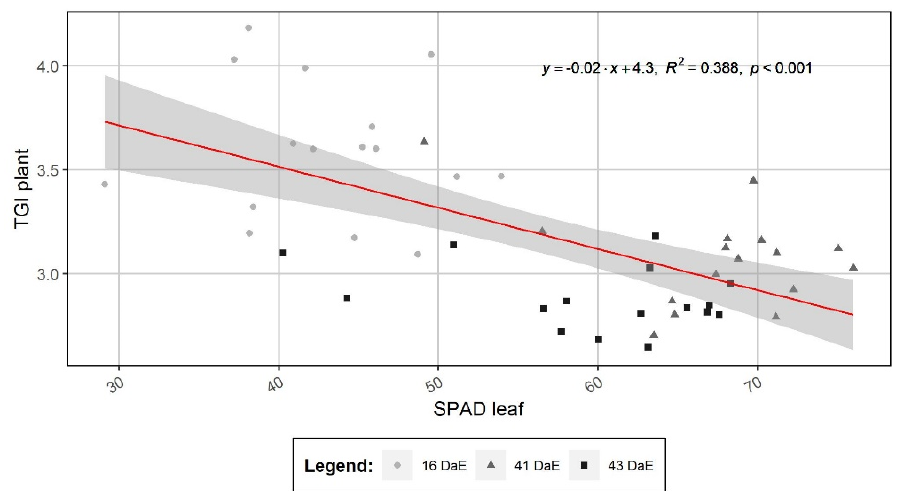
Figure 9. Relationship between the SPAD value measured on diagnostic leaves with an RGB camera and TGI of plants measured by imaging and time on 14 July, 8 and 10 August (after 16, 41 and 43 days after emergence, DaE) in a field experiment conducted with water yam (cv C18) in Tieningbou é (C ô te d’Ivoire) with different fertilizations and rotations. Each dot represents the average values for one plot or two plants. The grey band indicates the 95% confidence interval.